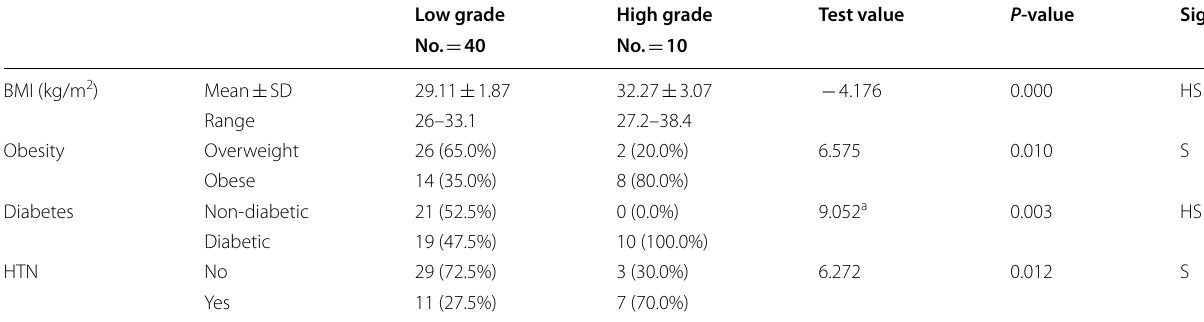
P -value > 0.05, non-significant; P -value < 0.05, significant; P -value < 0.01, highly significant a Chi-square test